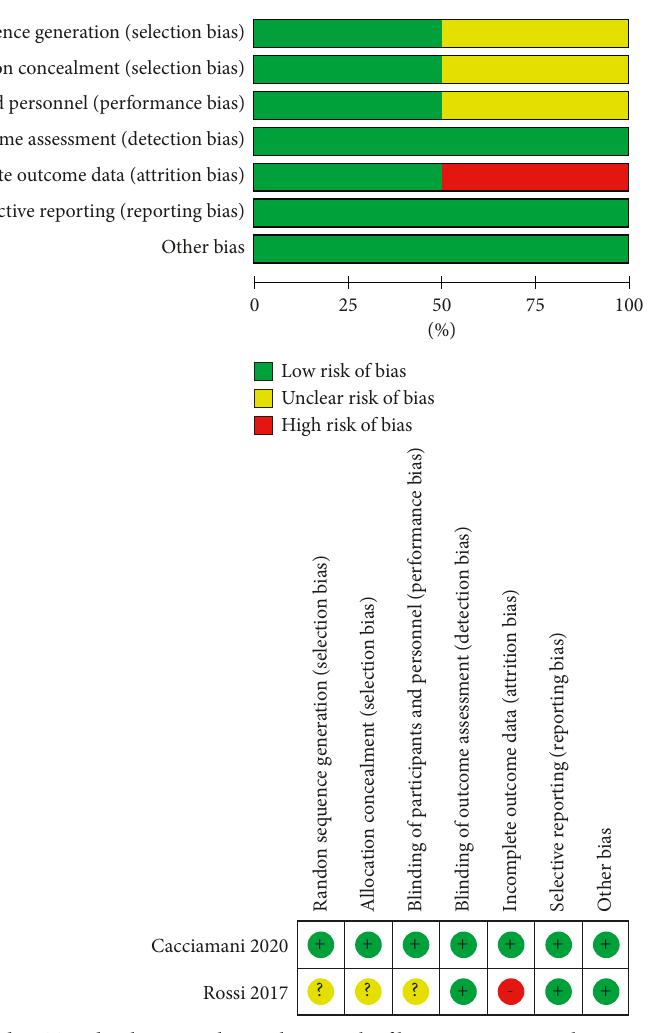
Figure 5: Evaluation of the bias in the included RCTstudies by using the Cochrane risk of bias assessment tool. Green presents a low risk of bias, yellow presents an uncertain risk of bias, and red presents a high risk of bias. Table 2: Newcastle-Ottawa scale for the retrospective